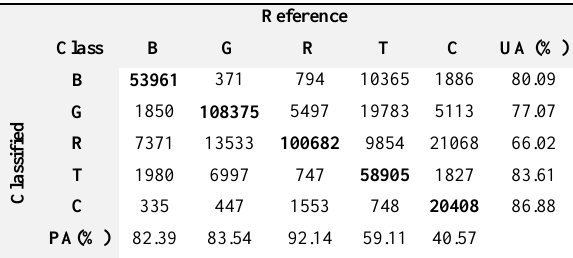
Table 1. Confusion Matrix of the MLP classifier. B=Buildings; G = Grasses; R = Roads; T = Trees; C = Cars; UA = User Accuracy; PA = Producer Accuracy.